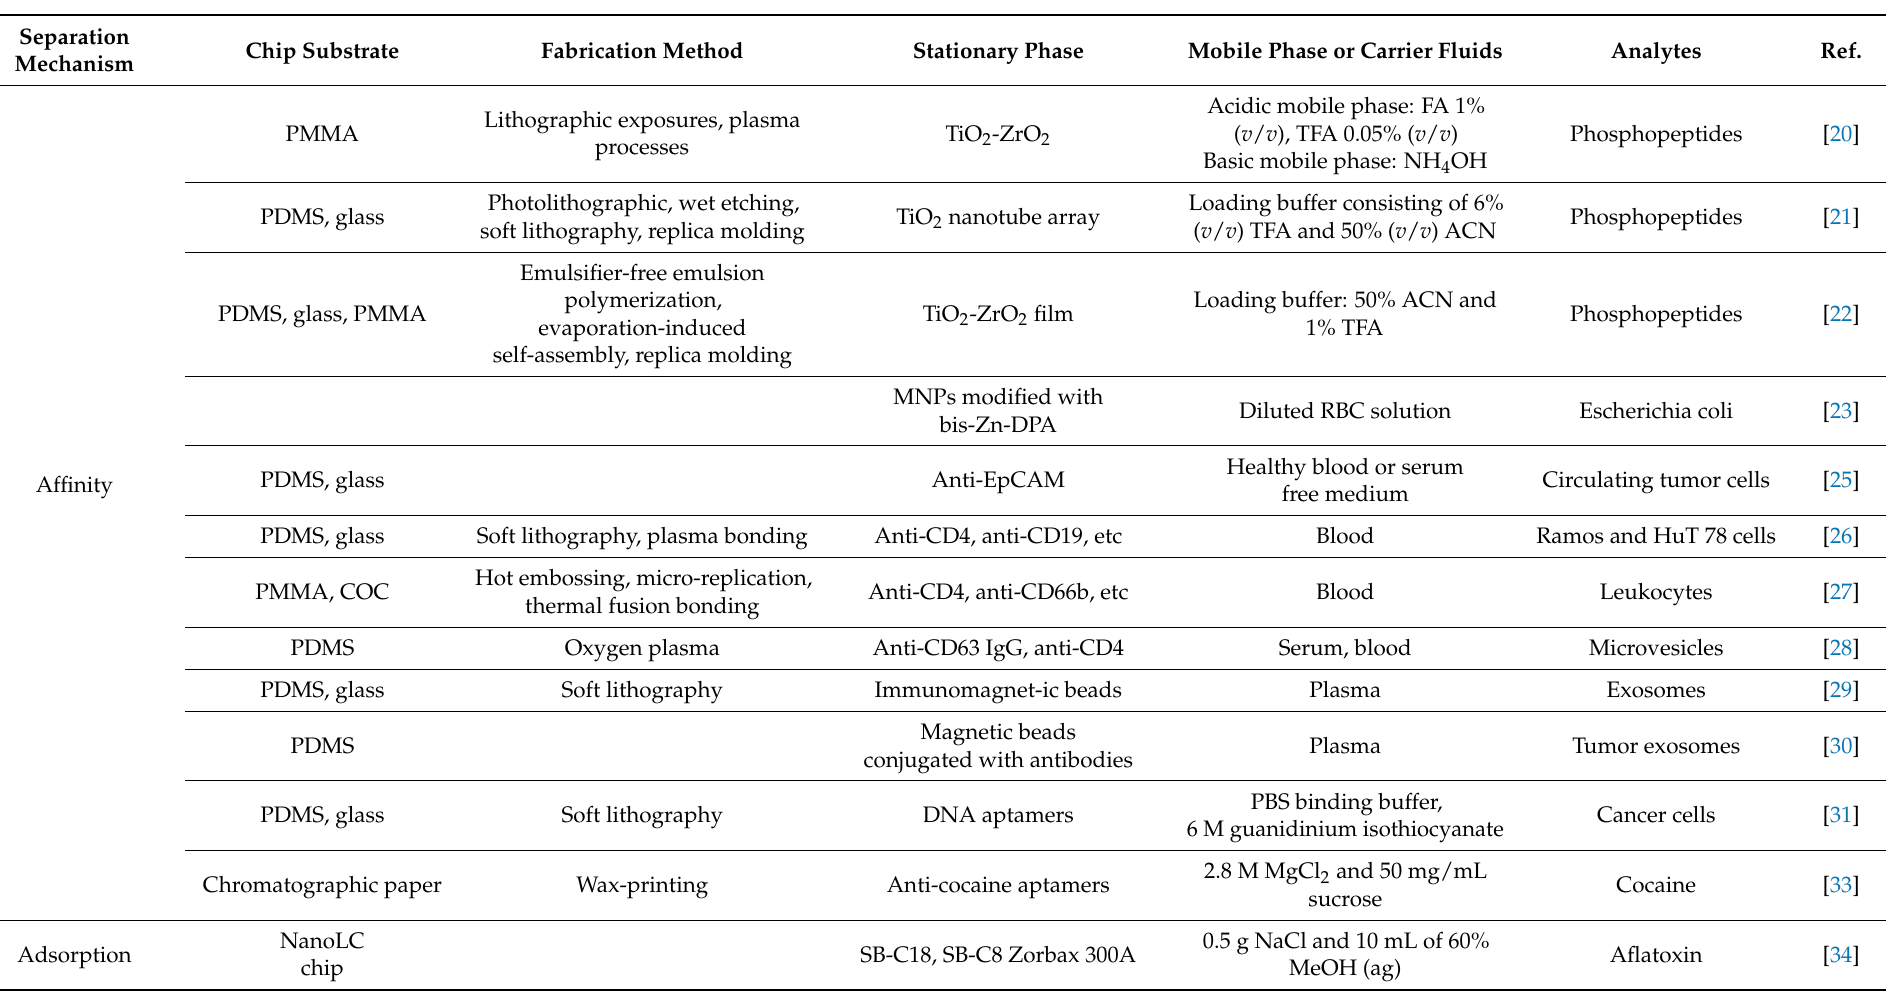
Table 1. A summary of microfluidics-based chromatography separation